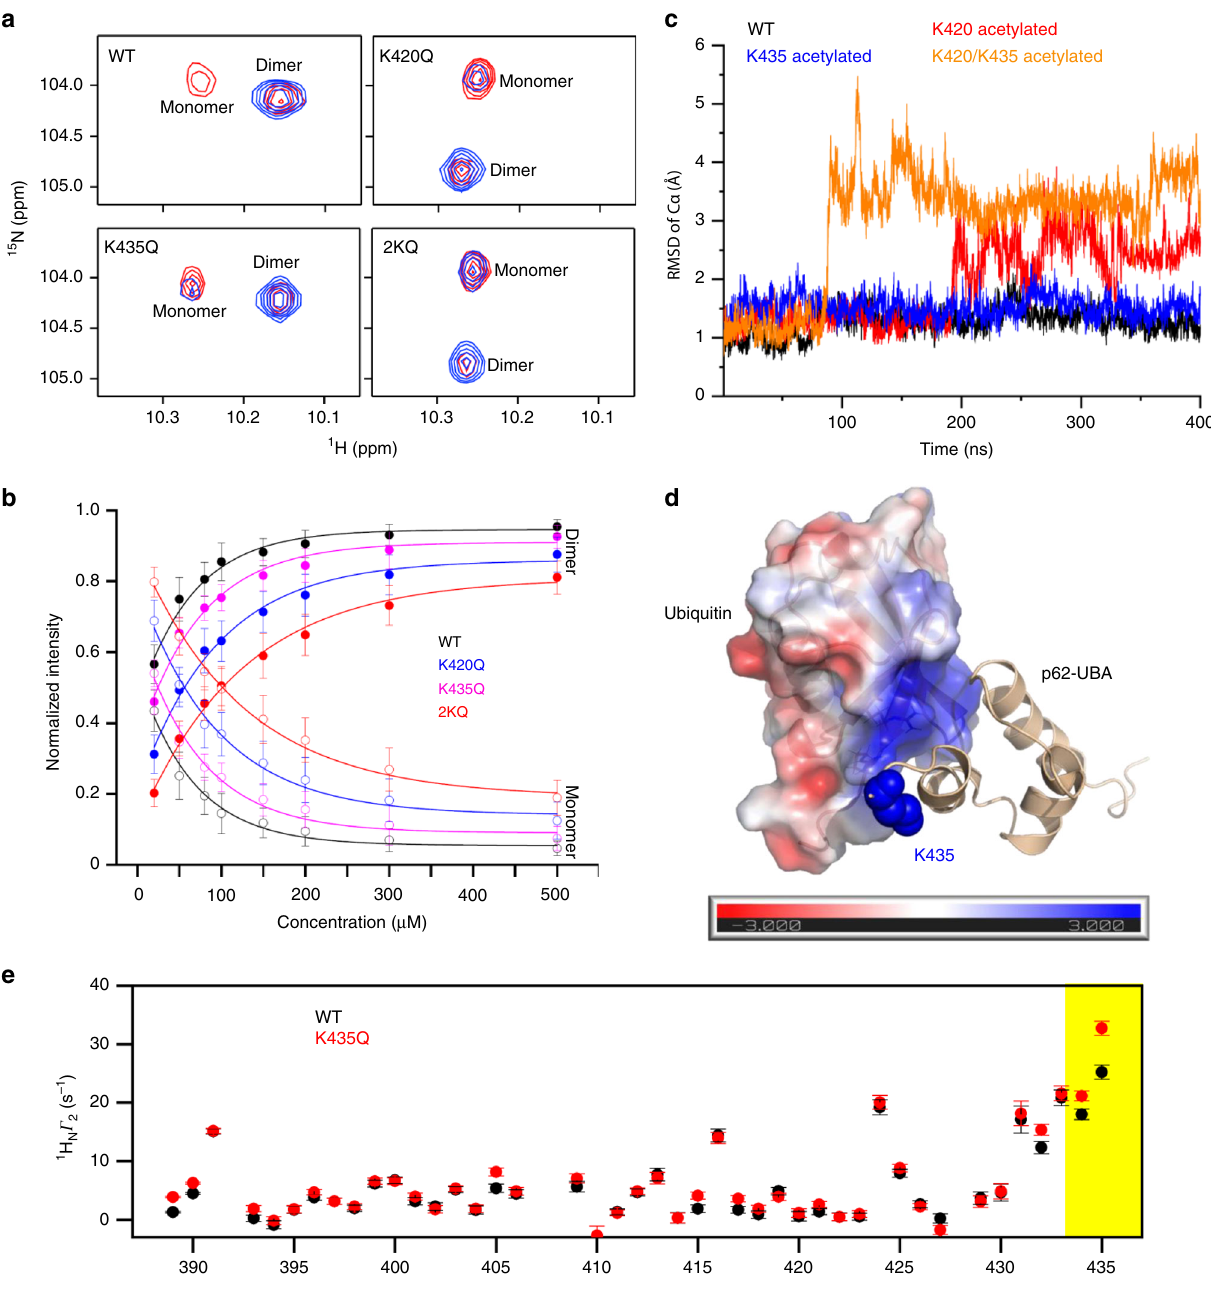
Fig. 6 Acetylation inhibits UBA dimerization and directly increases the af fi nity of p62 for ubiquitin. a The W12 H ε 1 -N ε 1 region of the 1 H- 15 N HSQC spectra of 15 N-labeled WT and acetylation-mimicking mutants of p62-UBA were measured at high (200 µ M, blue) and low (20 µ M, red) concentrations. b The dissociation constant of each of the indicated p62-UBA proteins was calculated based on the relative peak volumes for dimeric and monomeric species at different concentrations. The residues used for calculation are S399, L402, G405, S407, G411, W412, T419, and G425 H ε 1 -N ε 1 ; the error bars indicate 1S.D. in the averaged relative peak volume at each protein concentration. c Representative trajectories of MD simulation for WT, K420 acetylated, K435 acetylated and K420/K435 acetylated p62-UBA dimers. Fluctuations in C α RMSD of the dimer are plotted. d Structural model of the complex of p62- UBA and ubiquitin. The ubiquitin molecule is colored according to electrostatic potential, which is displayed on a scale from red ( − 3 kT/e) to blue ( + 3 kT/ e). The side chain of K435 in p62-UBA is shown as blue spheres. e Paramagnetic relaxation enhancement for the transverse relaxation rate Γ 2 of backbone amide protons for 15 N-labeled WT or K435Q mutant of p62-UBA in complex with isotopically unlabeled ubiquitin carrying a nitroxide spin radical tag at the E24C site. The error bars indicate 1S.D. in the fi tting of Γ 2 rates. The yellow shaded area indicates the unstructured C-terminal tail of p62. Source data are provided as a Source Data fi